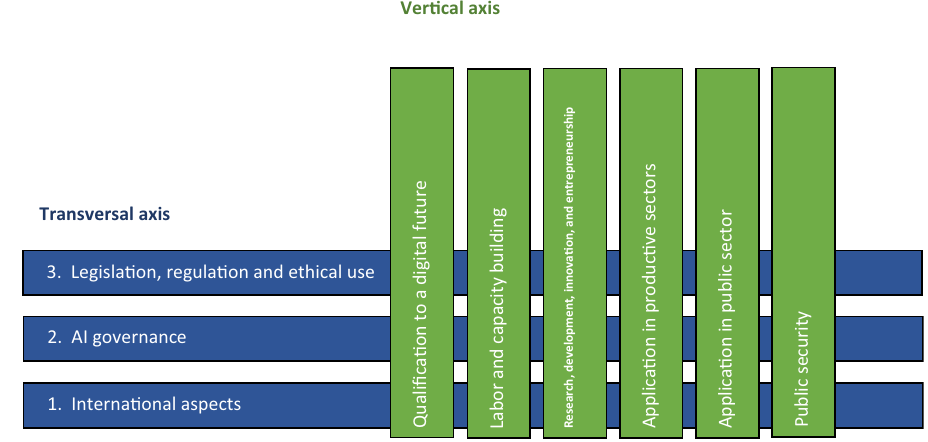
Fig. 2 Horizontal and vertical axes of EBIA. Source: Brazilian Strategy for Artificial Intel- ligence